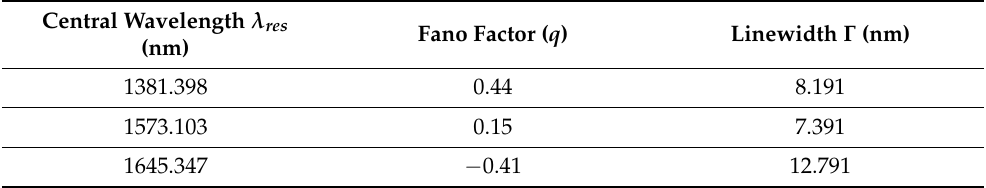
Figure 3. Transmission spectrum of the 3D-FDTD unit cell model of the nano-hole with d = 900 nm, r = 250 nm, and c = 300 nm. The transmission spectrum shows three narrow-band resonances appearing at 1381.398, 1573.103, and 1645.347 nm wavelength ranges. Table 1. The values of the parameters used in the Fano function to obtain the curve fitting for the three resonant modes are shown in Figure